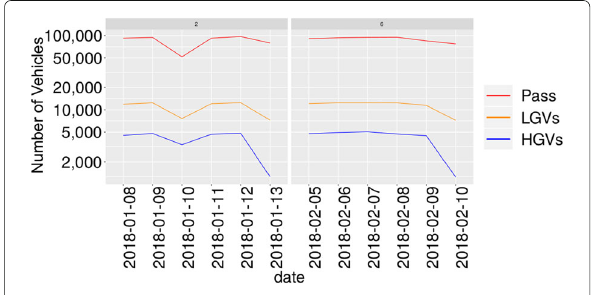
Fig. 6 Number of vehicles in the district